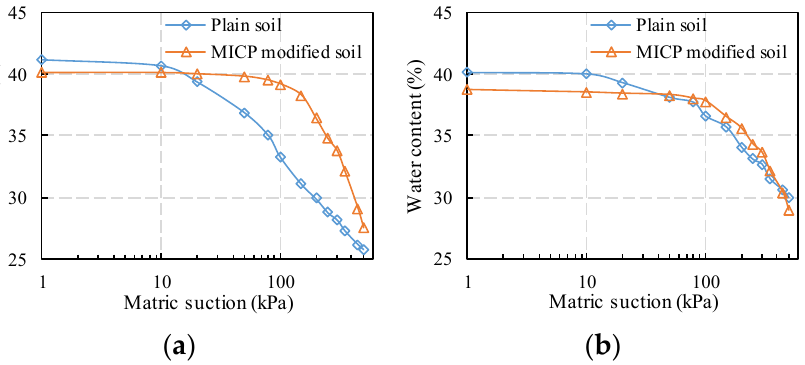
Figure 8. Comparison of SWCCs between plain soil and MICP improved soil with compactness of ( a ) 90% and ( b ) 95%.